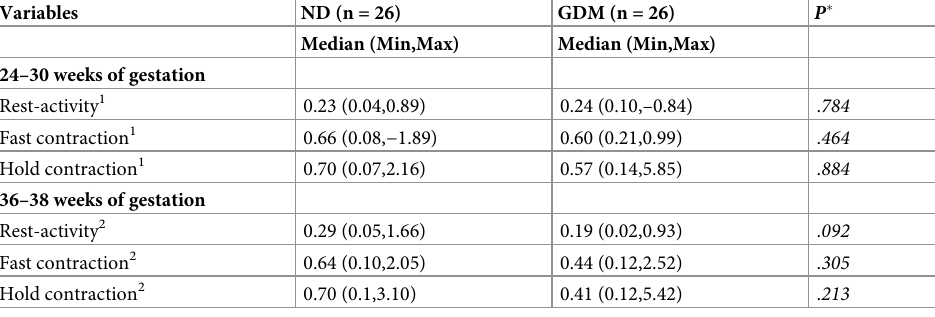
Data are the median (minimum, maximum) range.